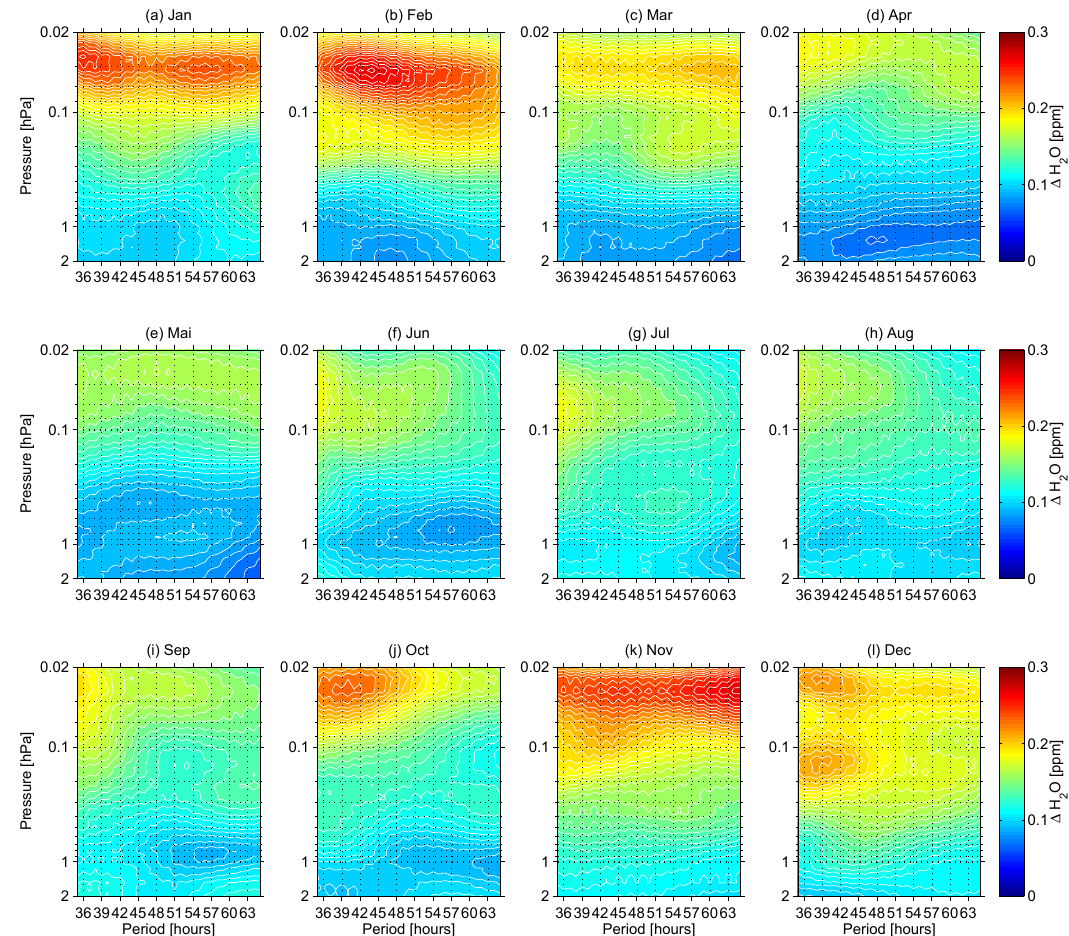
Figure 5. Monthly climatology (January to December, a–l ) of wave amplitude spectra for periods between 35 and 65h over a period